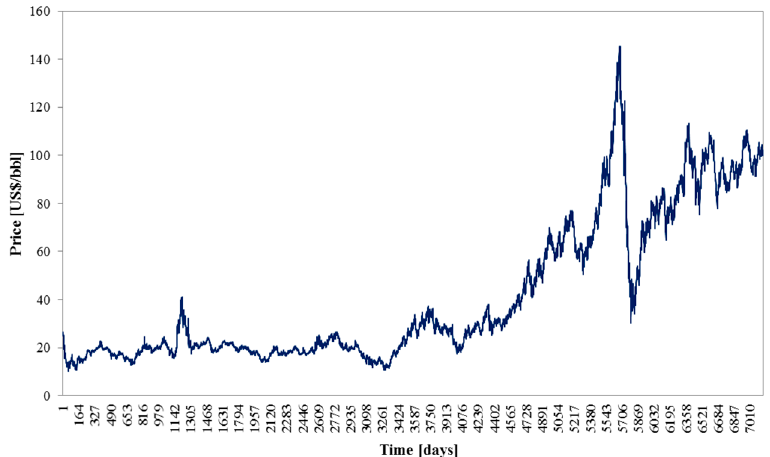
Figure A1. Historical data for crude oil price for approximately twenty-eight years [45].